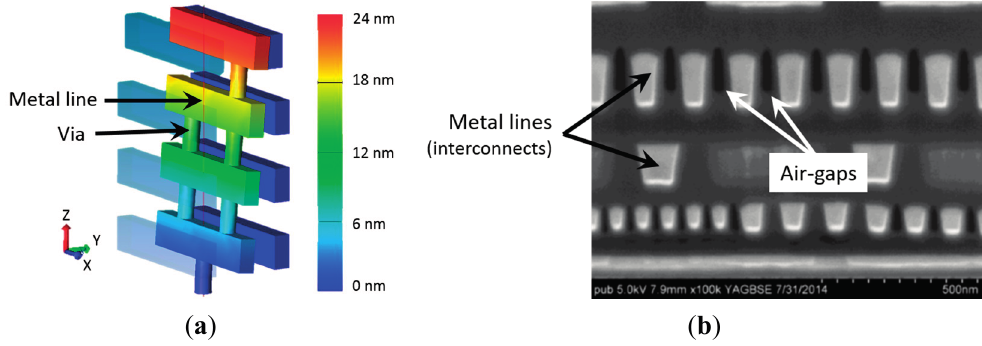
Figure 10. ( a ) New vertical NEM relay structure using BEOL metal layers (adapted from [68]). ( b ) The most advanced BEOL technology incorporates air-gaps between metal interconnects [71] (© 2014 IEEE, reprinted with permission from